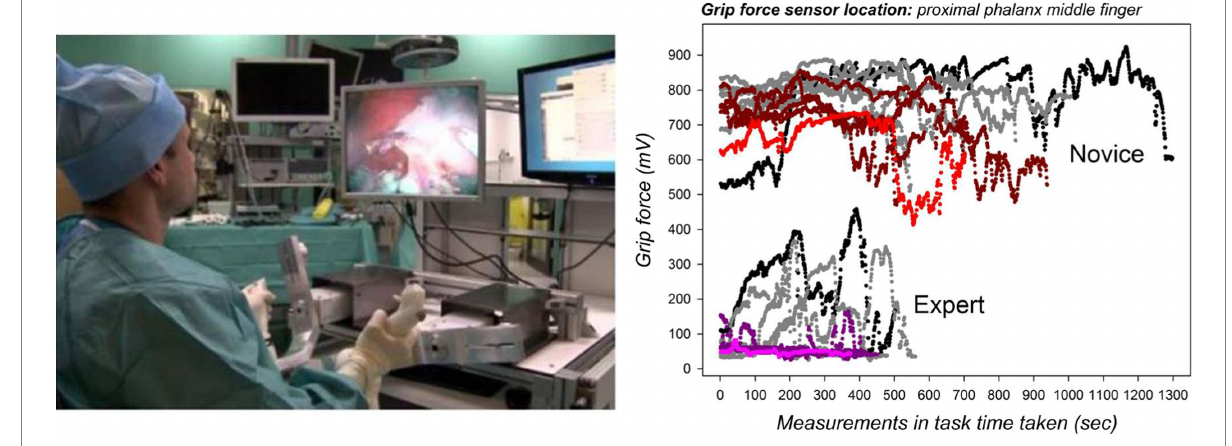
FIGURE 2 Distinct spatio-temporal grip force patterns (on the right) tell the skilled expert from the novice at a glance in 2D image-guided robot-assisted (left) simulations in a 3D surgical task space (De Mathelin et al., 2019; Dresp-Langley et al., 2020). The ten graphs plotted for each individual represent grip forces sampled every 20 ms in ten successive training sessions from these studies. The colored graphs indicate the individual grip forces from the last session. Human-robot interaction represents a task context that profoundly challenges solidly formed perceptual, somatosensory, and cognitive representations of space, scale, and relative distance for sensori-motor coordination. Image (left) source: Liu and Dresp-Langley (2021) (CC-BY